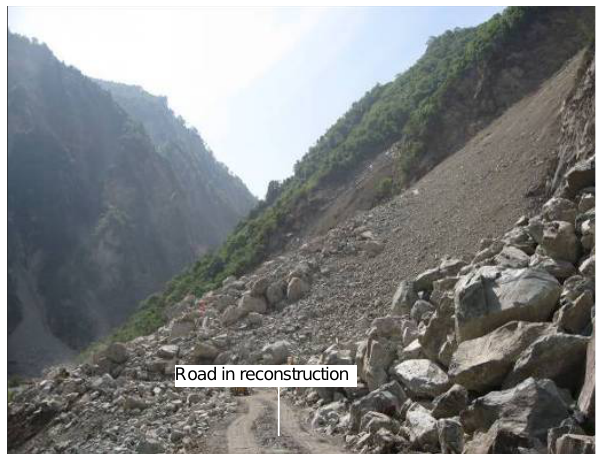
Fig. 4. Lithology and faults in the study area.